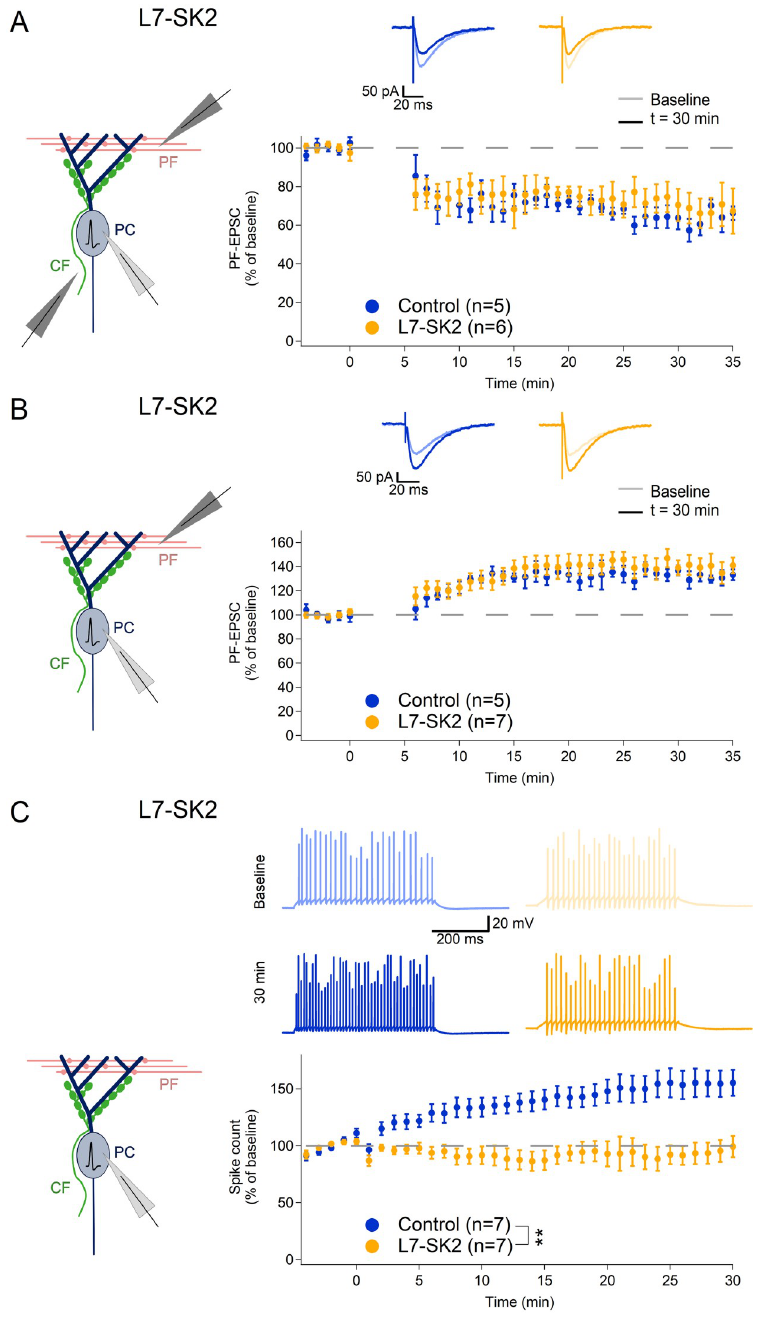
Fig 4. Intrinsic plasticity is selectively impaired in L7-SK2 PCs. (A) Similar to SK2-KO cells (Fig 3), L7-SK2 PCs express LTD at PF synapses at comparable levels to control littermates (induction protocol: 1-Hz paired PF + CF single pulse, 5 min). Upper panel: representative traces of PF-EPSCs. Lower panel: time graph of PF-EPSCs (averaged per minute) before and after the induction (at 0 min). (B) LTP is induced at comparable levels at PF synapses in L7-SK2 PCs and control littermates (induction protocol: 1-Hz PF single pulse, 5 min). Upper panel: representative traces of PF-EPSCs. Lower panel: time graph of PF-EPSCs as in A. (C) Intrinsic plasticity cannot be induced in L7-SK2 PCs by a somatic depolarization protocol. Upper panel: representative traces of spikes evoked by a somatic depolarizing current injection of fixed amplitude, before (upper) and after (lower) the induction protocol. Lower panel: time graph of spike count (averaged per minute) before and after the induction (at 0 min). �� p < 0.01. CF, climbing fiber; EPSC, excitatory postsynaptic current; KO, knockout; LTD, long-term synaptic depression; LTP, long-term potentiation; PC, Purkinje cell; PF, parallel